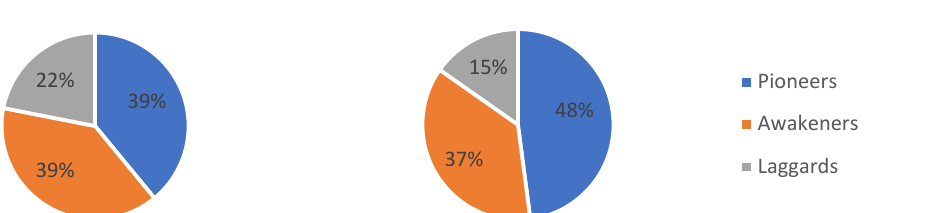
Figure 10. Sustainability clusters in the sample for the present and for the foreseeable future. Source: edited by authors.